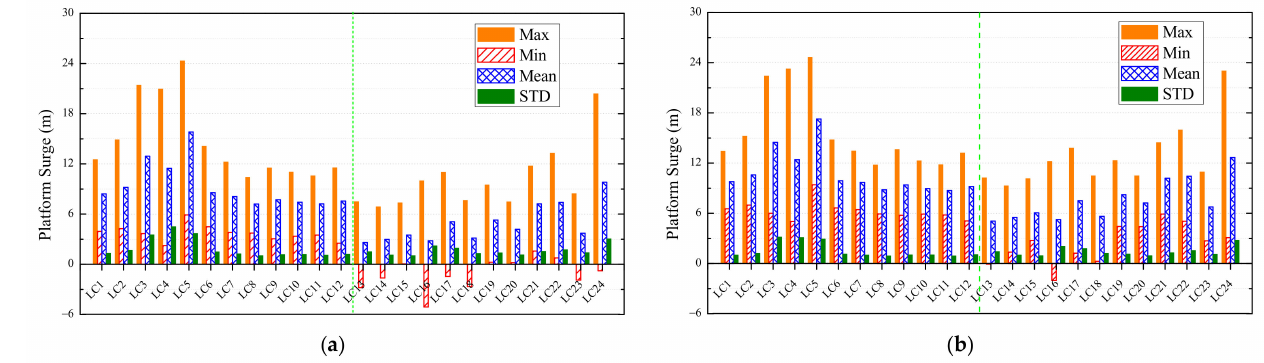
Figure 11. Statistics of platform surge motion response for ( a ) without current; ( b ) with current.